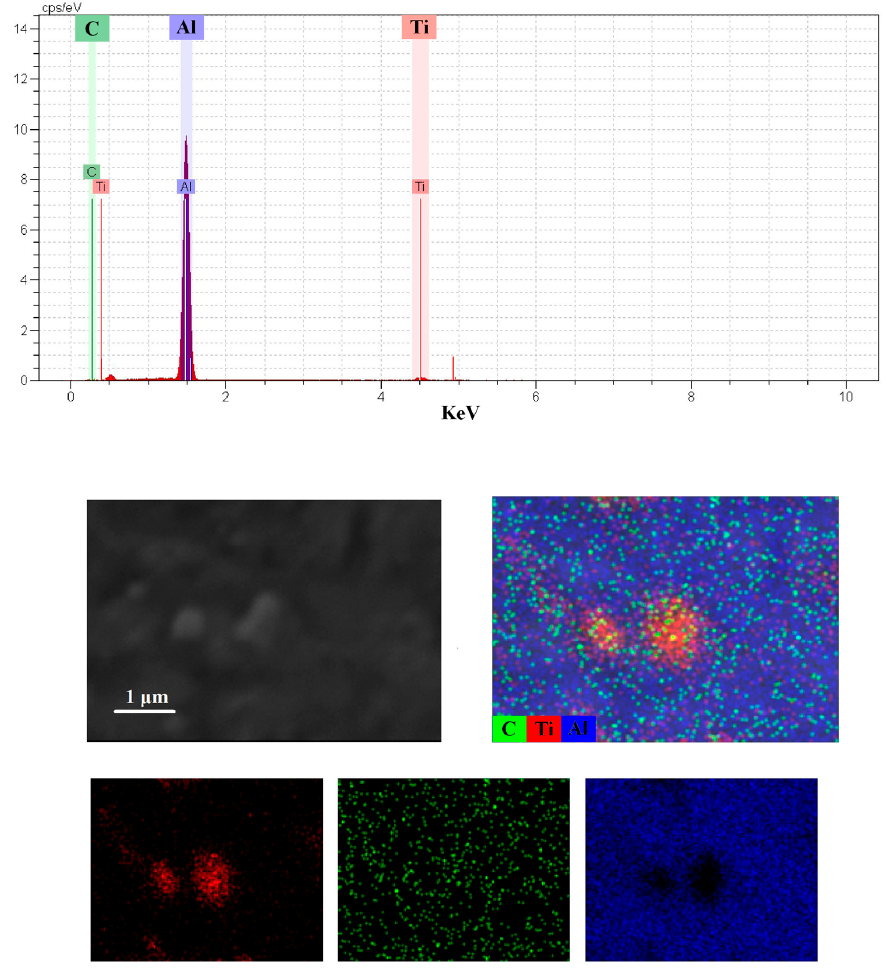
Figure 8. Backscattered and EDS elemental mapping of the spark plasma sintered sample.